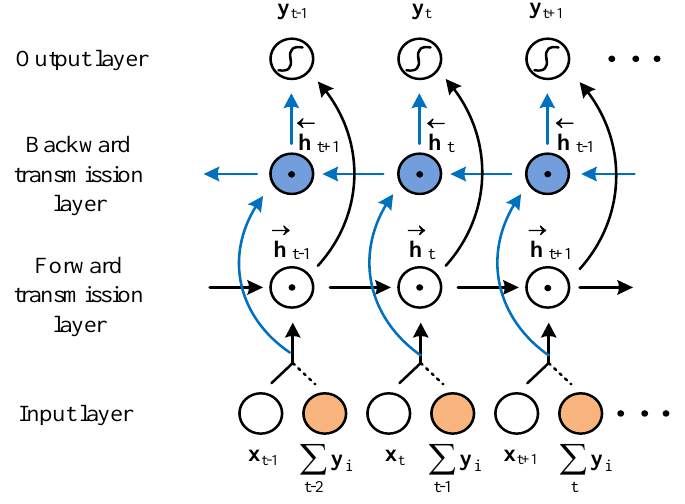
Figure 6. Structure of B-IRRNN model unfolded by time.